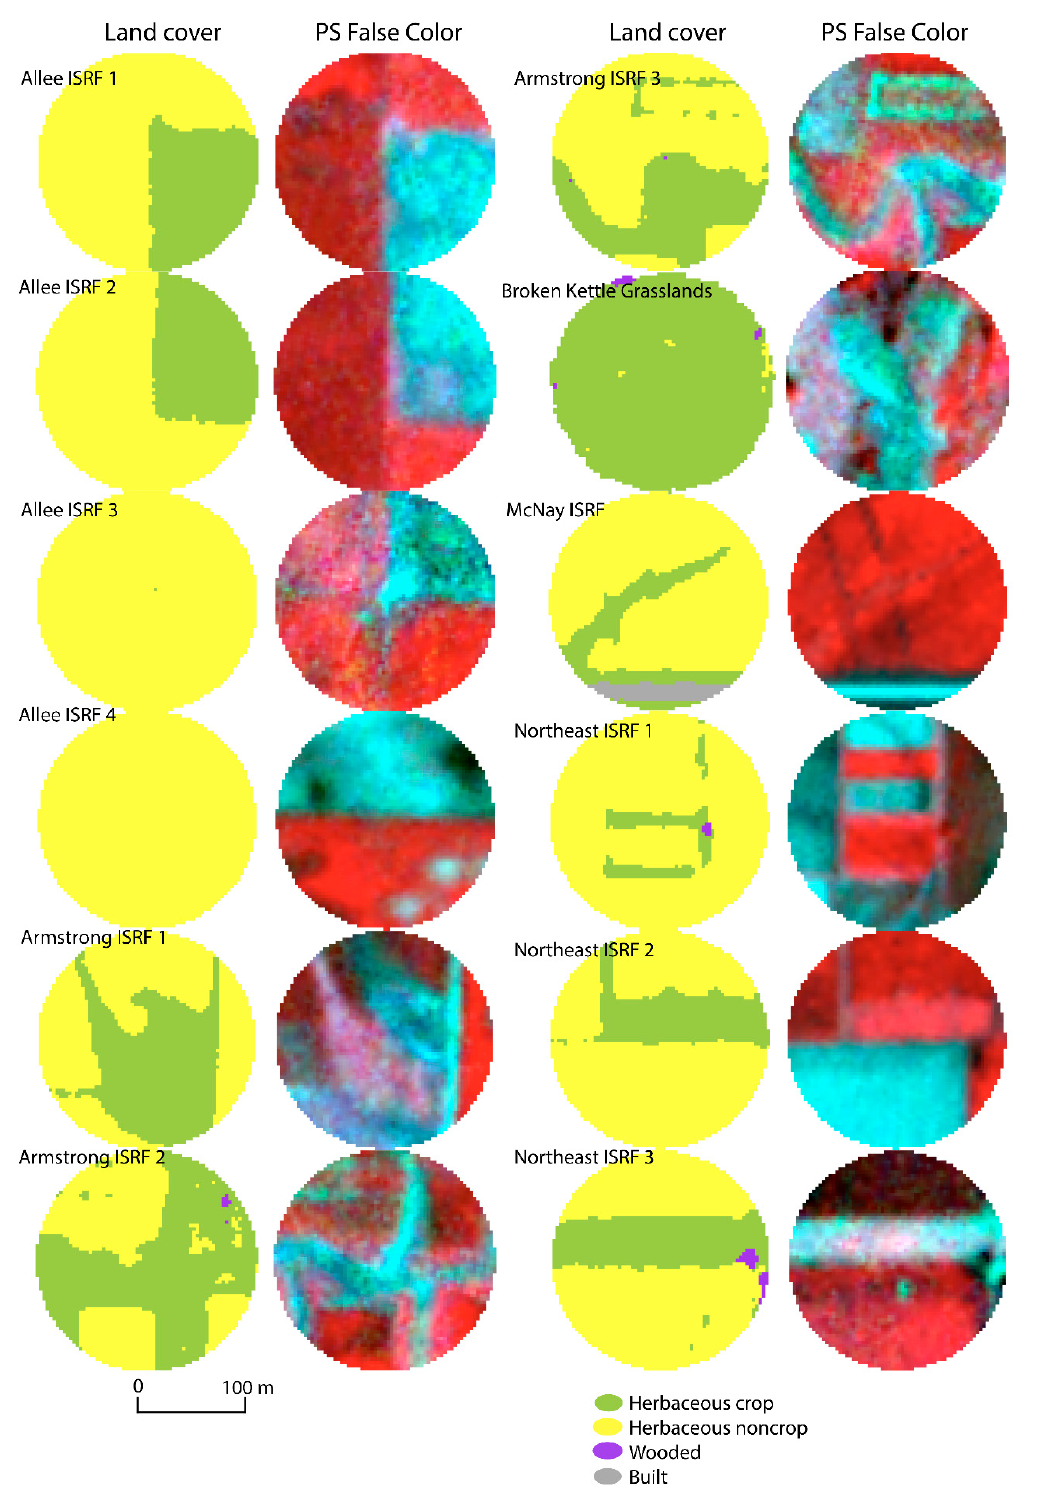
Figure 7. PlanetScope (PS) land cover maps and false color images.